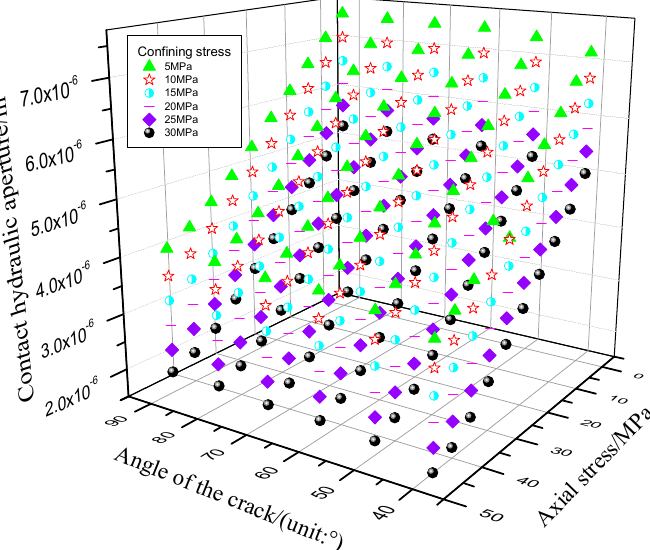
Figure 22. Average joint aperture values of different angle crack models.